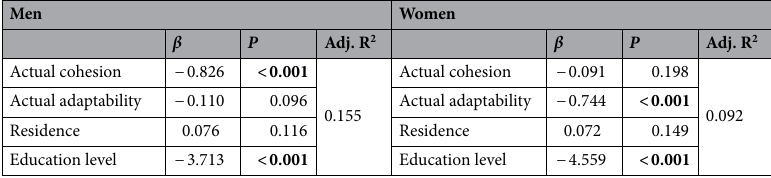
Actual cohesion − 0.237 ( < 0.001 ) Actual adaptability Table 7. Pearson correlation analysis between infertility-related stress and family cohesion, family adaptability. Significant values are given in bold.